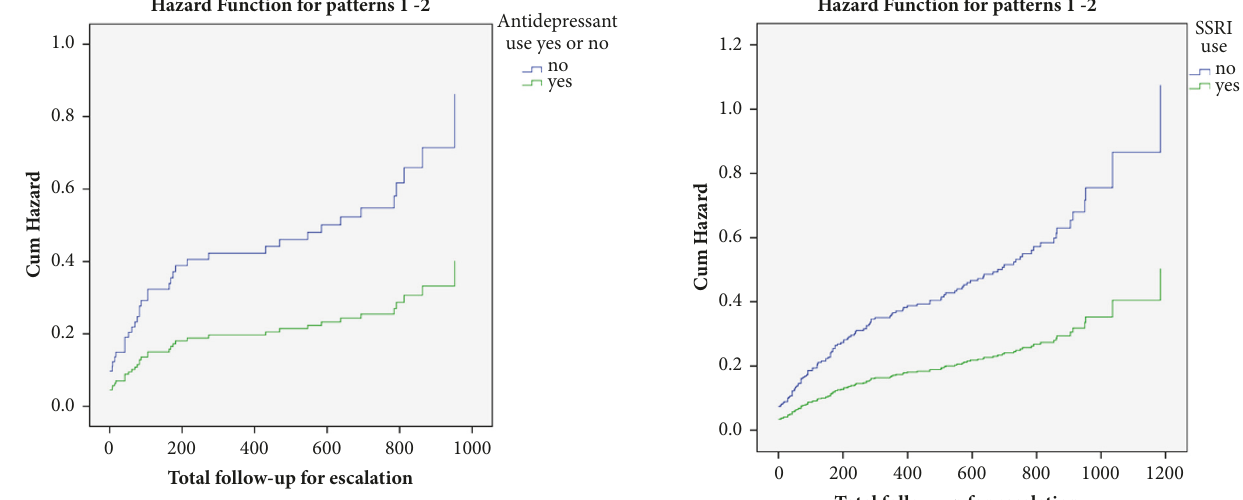
Figure 3: Cumulative hazard for escalation of medical therapy in response to uncontrolled IBD between patients receiving or not receiving